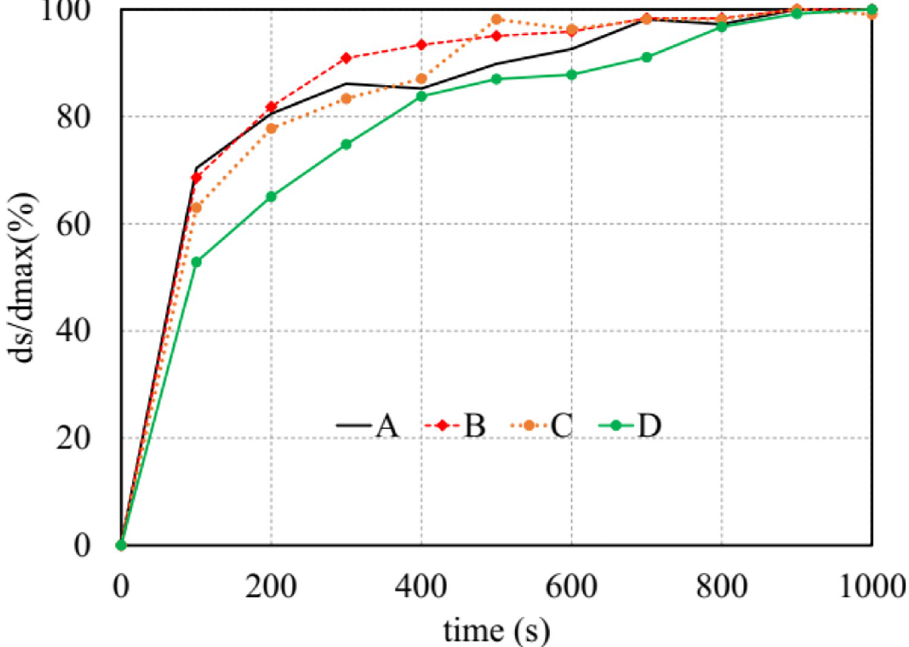
Fig 8. The influence of diversion walls on computational